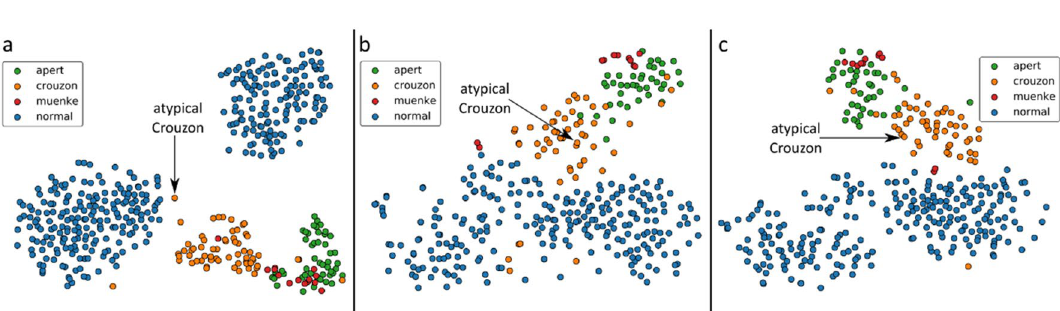
Figure 3. t-SNE embeddings for all samples, including the atypical Crouzon case, for the face-only ( a ), head- only ( b ), and combined head-and-face ( c ) models.